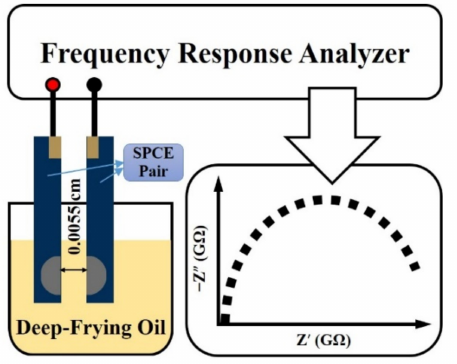
Figure 1. Schematic diagram of the EIS measurement